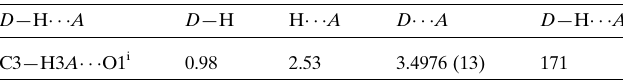
Table 1 Hydrogen-bond geometry (A˚ , (cid:5)